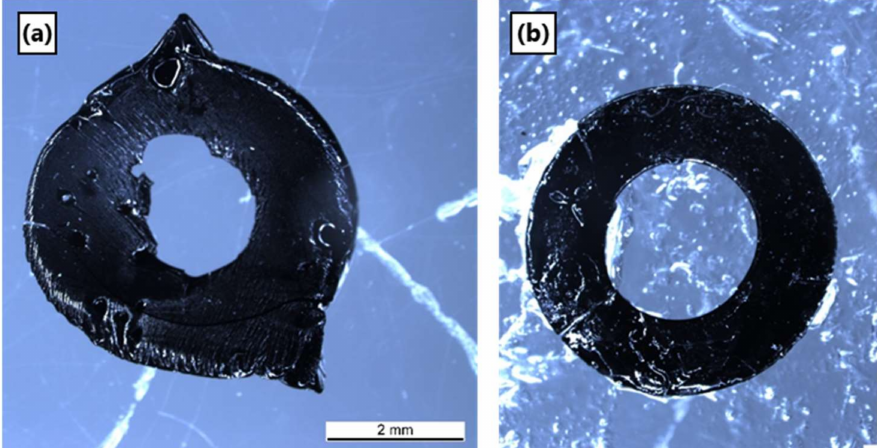
Figure 11. SiCN ceramics sintered with slow heating/ cooling ramps alone ( a ) and with an additional pre-sinter thermal crosslinking step ( b